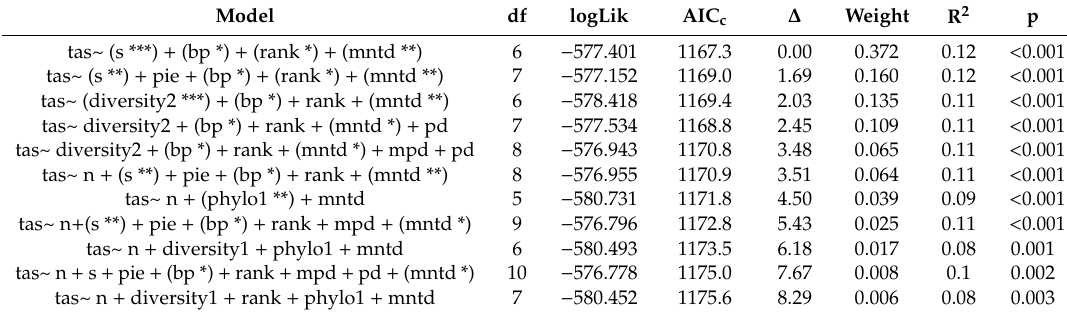
Table 1. Model selection using Akaike Information Criterion (AIC c ) to predict hantavirus prevalence in small mammal assemblages at the global scale. The models suggest the identity of each species (s) and phylogenetic relatedness (mntd; mpd; pd) of dominant hosts (bp; rank) are informative predictors of assemblage prevalence (tas). Principal component analysis was used to avoid multicolinearity of covariates (diversity1; diversity2; phylo1). Models are listed in order of decreasing comparative weights.